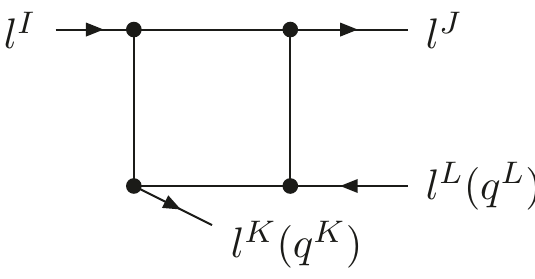
Figure 4 . Box diagrams with external charged leptons or